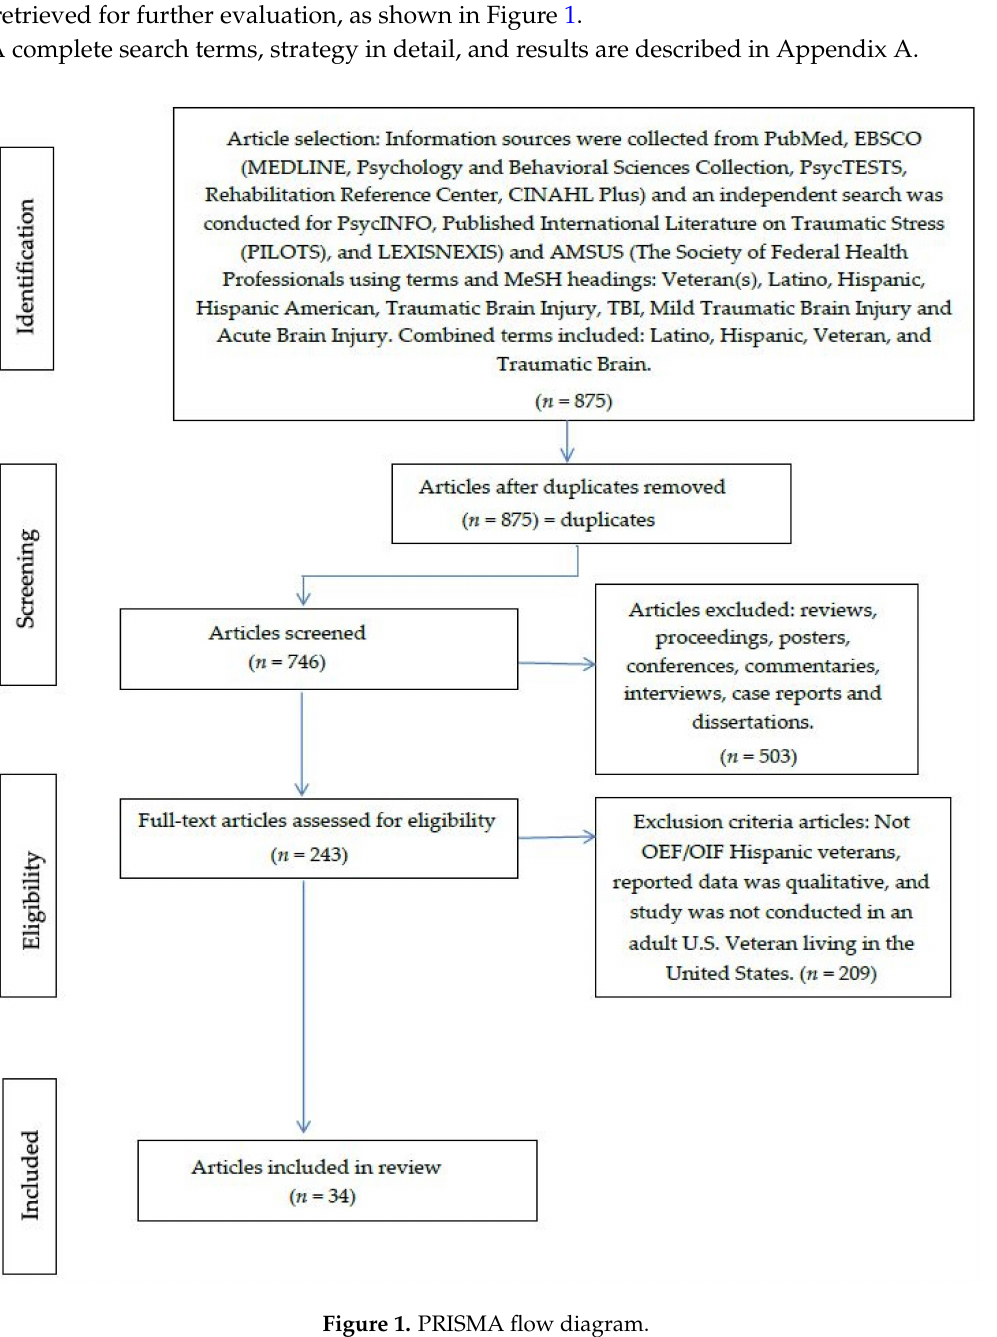
Figure 1. PRISMA flow